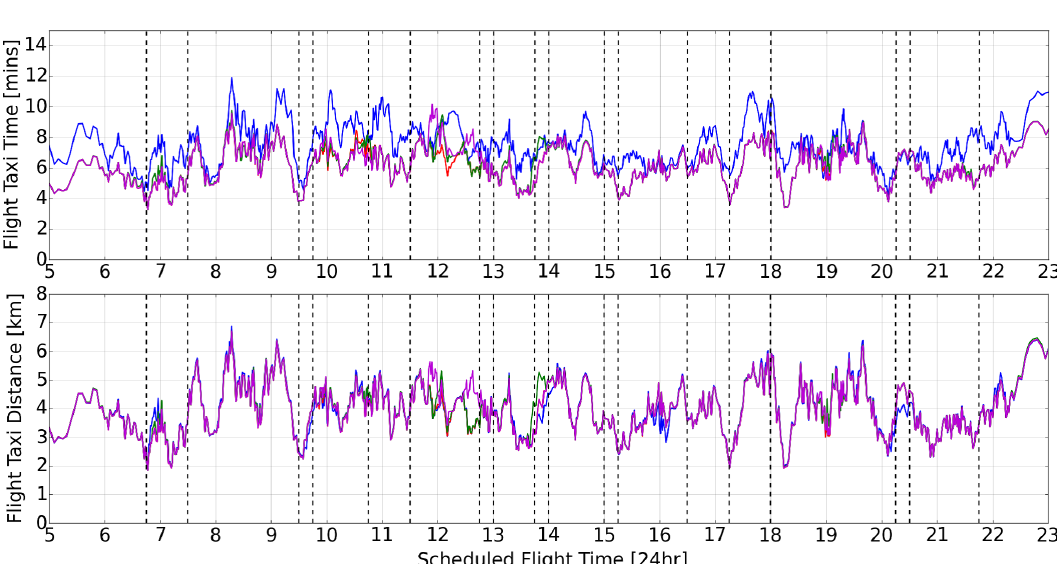
Figure 8. Moving average flight taxi time and taxi distance results, grouped per 10 flights for the real-world and MAS simulation results of 2 May 2016. Blue line: real-world performance, red line: Conflict-Based Search (CBS) mechanism performance, green line: CBS + Merging Point Highways (MP HWYs) mechanism performance, purple line: CBS + Conflict-Based Highways (CB HWYs) mechanism performance. Dotted vertical lines represent the runway reconfiguration